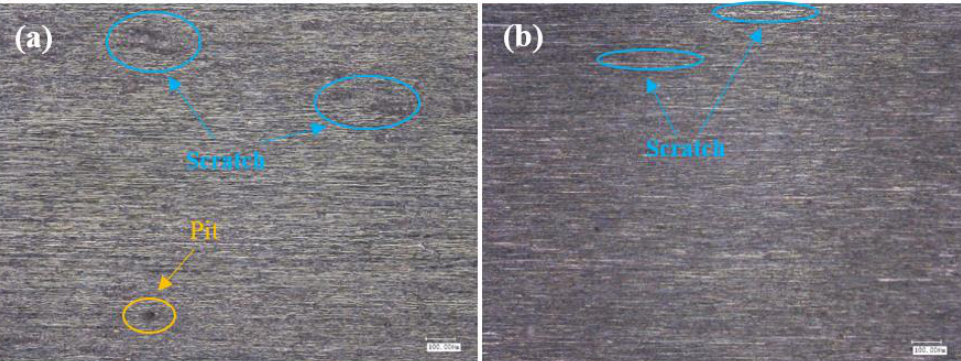
Figure 14. ( a ) The surface of test 1, ( b ) the surface of test 2.